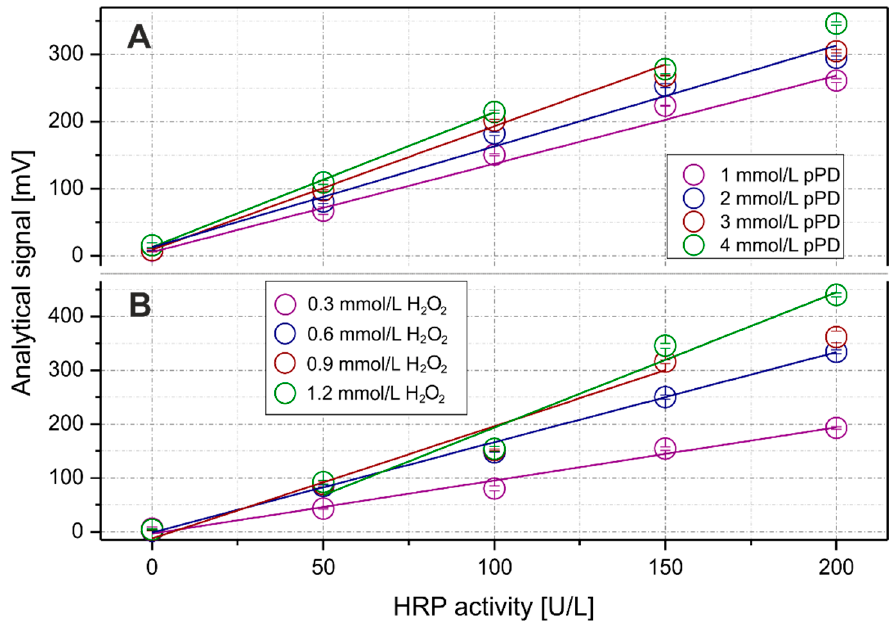
Figure 3. The optimization process of enzymatic reaction: the effects of pPD concentration (with 0.6 mmol/L H 2 O 2 , ( A )) and hydrogen peroxide (with 2 mmol/L pPD; ( B )) on obtaining analytical signals. Error bars represent one standard deviation for n = 3.